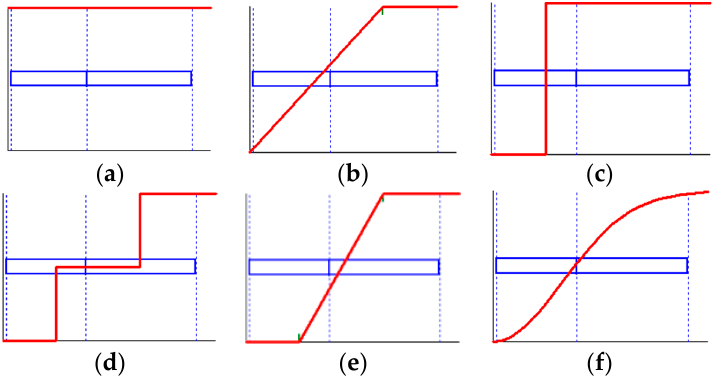
Figure 1. Types of preference functions. ( a – c ) Usual V shape U shape, ( d – f ) level linear Gaussian.